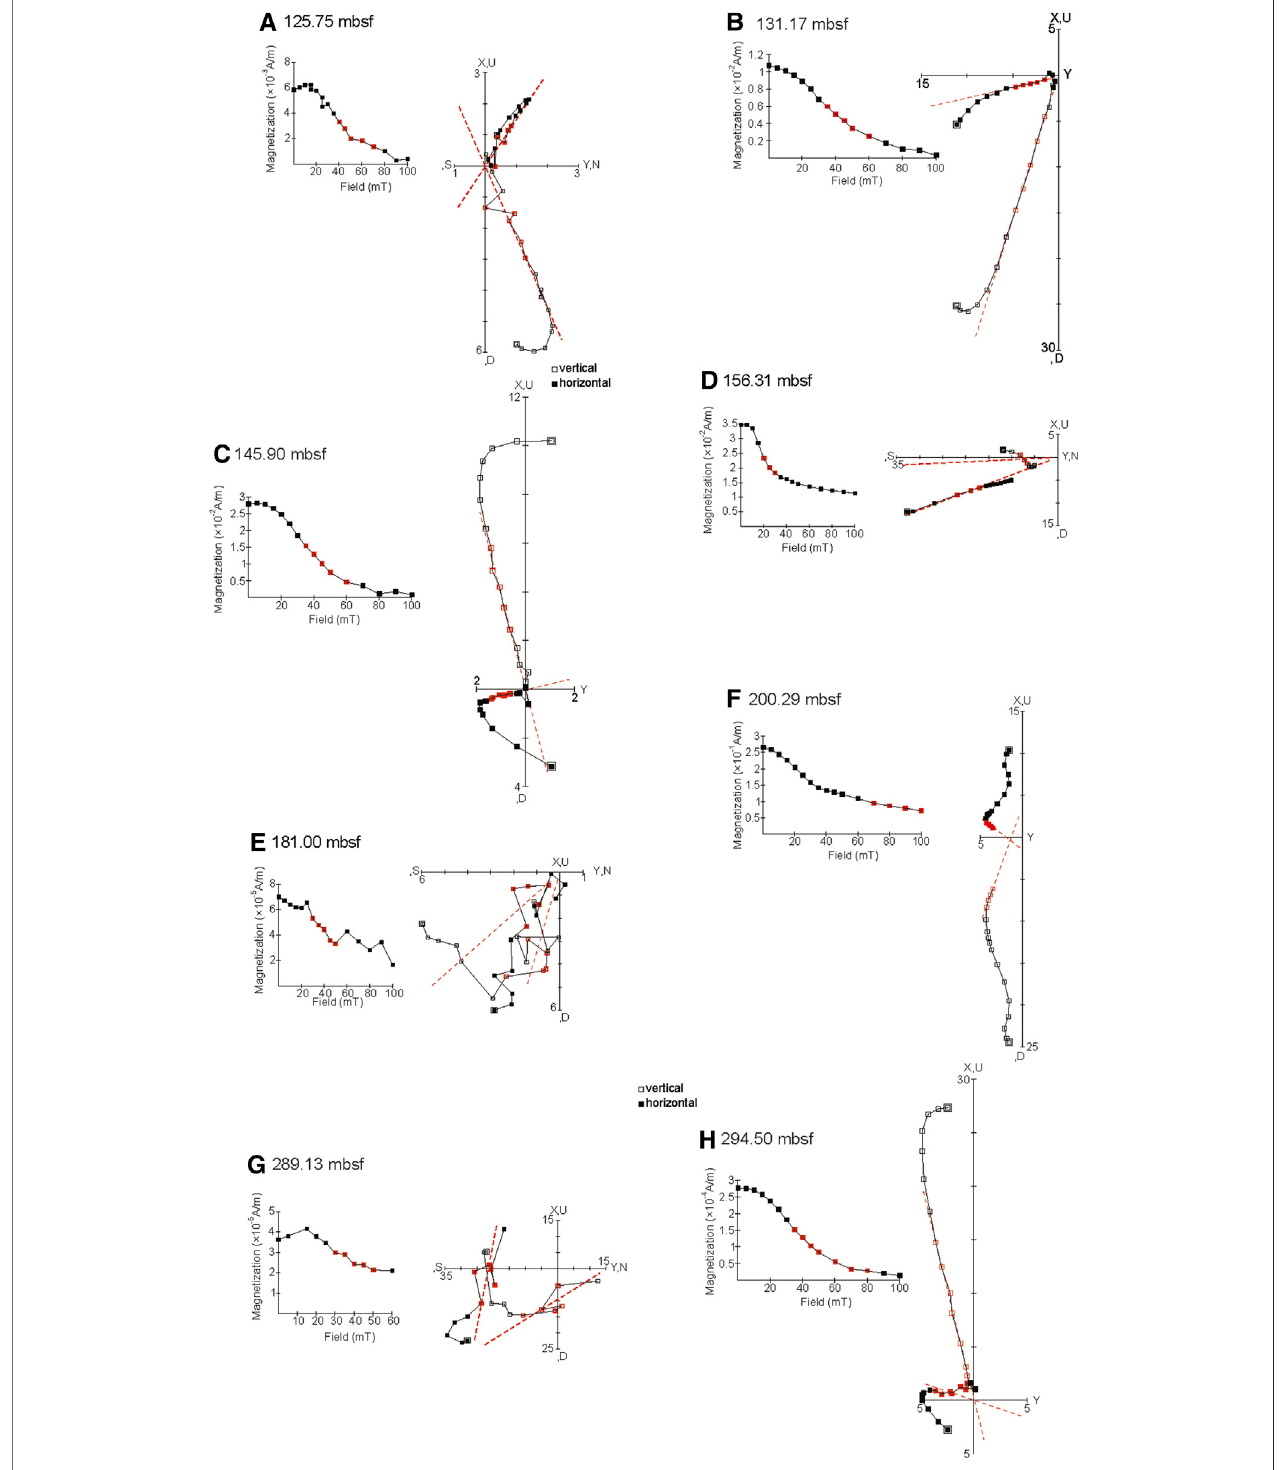
FIGURE4| AF(alternating fi eld)demagnetizationbehaviorforeightrepresentativesamples.Forthevectorcomponent diagrams,open(closed)symbolsrepresent projections onto the vertical (horizontal) plane. The red dashed lines represent PCA fi ts that indicate the ChRM direction for each sample. A) , F) , B) examples of reverse polarity. C) , H) , E) , G) examples of normal polarity; Samples A) , E) G) are noisy but it is possible to identify a ChRM. Sample D) has a radial overprint that resists AF demagnetization. The cores were not azimuthally oriented and declinations are, therefore, arbitrary. See text for discussion.